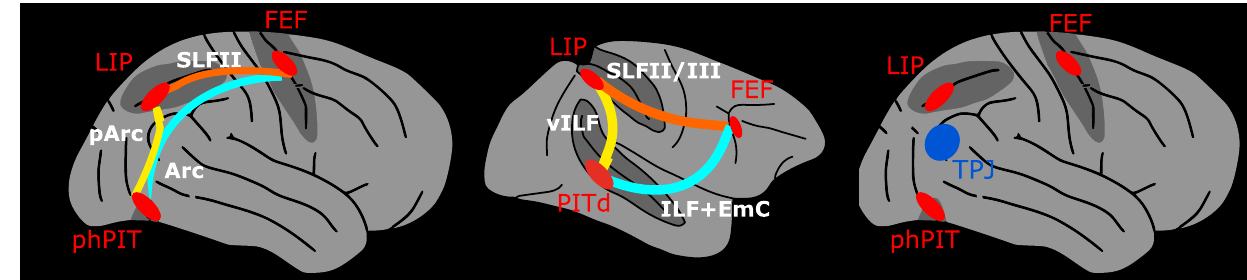
Fig. 8 Human extended endogenous attention network. Whole brain model and structural connectivity of the attention network as de fi ned by functional activation (red areas) and structural connectivity in humans (leftmost panel) and macaques for comparison (middle panel). Colored solid lines represent connections and pathways between attention nodes phPIT, LIP, and FEF. The rightmost panel shows the spatial relationship between the extended endogenous attention network (red areas) and the TPJ, the most posterior node of the exogenous attention network (blue area) 9 . FEF Frontal Eye Field, LIP Lateral Intraparietal area, phPIT putative human Posterior Infero-Temporal area, Arc Arcuate Fasciculus, EmC Extreme Capsule, ILF Inferior Longitudinal Fasciculus, pArc posterior Arcuate Fasciculus, SLF Superior Longitudinal Fasciculus, vILF vertical branch of the Inferior